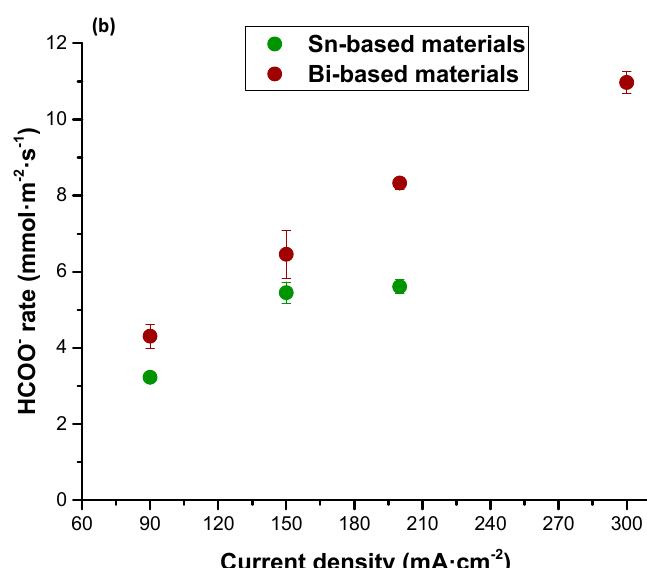
Figure 1. Influence of current density on ( a ) Faradaic E ffi ciency for HCOO − (%) and ( b ) HCOO − rate (mmol · m − 2 · s − 1 ) in the current density range of 90–300 mA · cm − 2 operating with an electrolyte flow = 5.7 mL · min − 1 . Sn / C-GDEs and Bi / C-GDEs are indicated in green and red, respectively. Data taken from